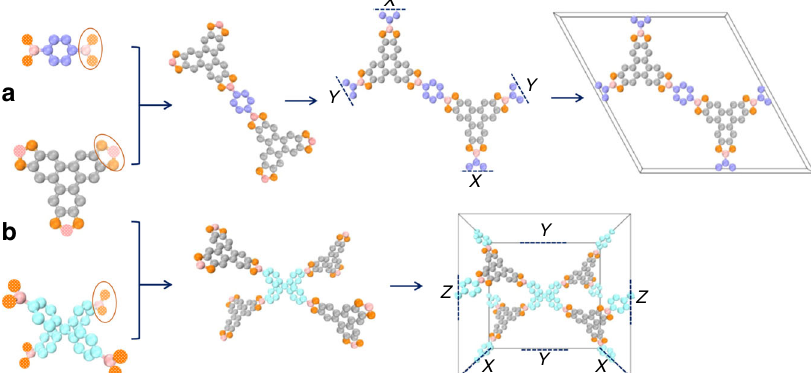
Fig. 2 Processes for 2D- and 3D-COF constructions using the method of QReaxAA. a The two GSUs on the left can be combined stepwise to construct a 2D-COF framework. When fi nding respective repetitive connectivity in X and Y directions, a periodic boundary is imposed on each direction to connect the GSUs located at both sides. The overall structure is formed by applying the third periodic boundary using the interlayer spacing arranged from our self- adaption algorithm. b The two GSUs can be combined to generate a 3D-COF framework. The combination step is similar to that of 2D-COFs but with three periodicities need to